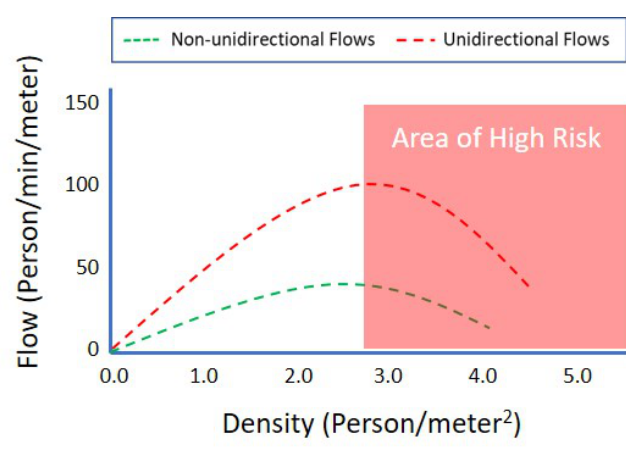
Figure 3. Crowd density illustration.